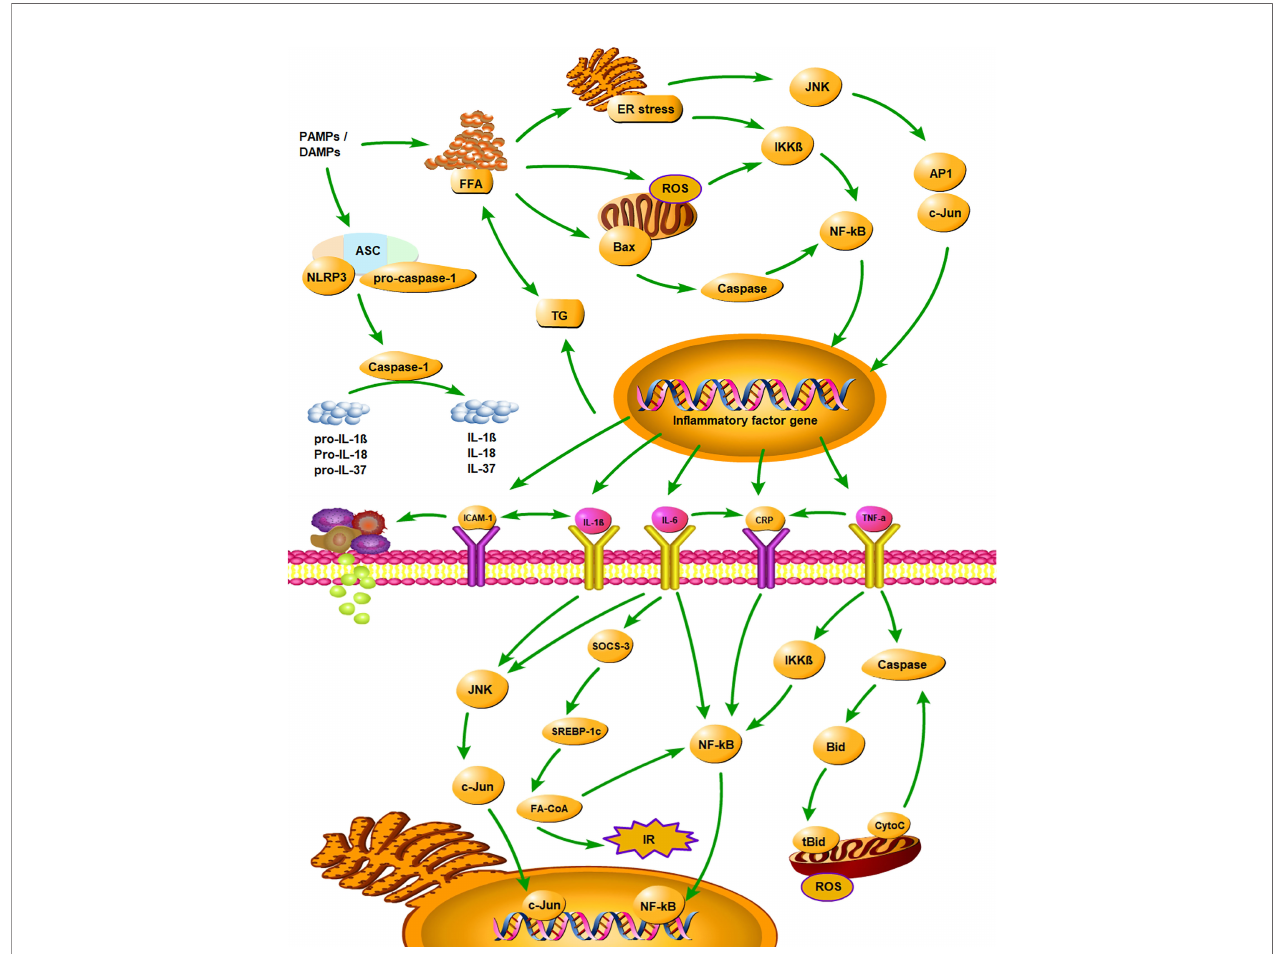
FIGURE 5 | Summarizes the mechanism of in fl ammatory cytokines and NLRP3 in fl ammasome in the development of NAFLD. PAMPs, pathogen-associated molecular patterns; DAMPs, danger associated molecular patterns; ASC, apoptosis-associated speck-like protein containing a CARD; CARD, caspase recruitment domain; FFA, free fatty acid; TG, triglyceride; ER stress, endoplasmic reticulum stress; ROS, reactive oxygen Species; IR, insulin resistance; IKK b , inhibitor kappa B kinase beta; NF- k B, nuclear factor k B; JNK, c-Jun N-terminal kinase; AP1, activator protein 1; SOCS-3, suppressor of cytokine signalling-3; SREBP-1c, sterol regulatory element binding protein-1c; FA-CoA, fatty acyl-CoA; Bid, BH3 interacting-domain death agonist; tBid, truncated BH3 interacting-domain death agonist; CytoC, Cytochrome-C; CRP, C ‐ reactive protein; IL-1 b , interleukin ‐ 1 b ; IL-6, interleukin ‐ 6; IL-18, interleukin ‐ 18; IL-37, interleukin ‐ 37; TNF- a , tumor necrosis factor ‐ a ; ICAM ‐ 1, intercellular adhesion